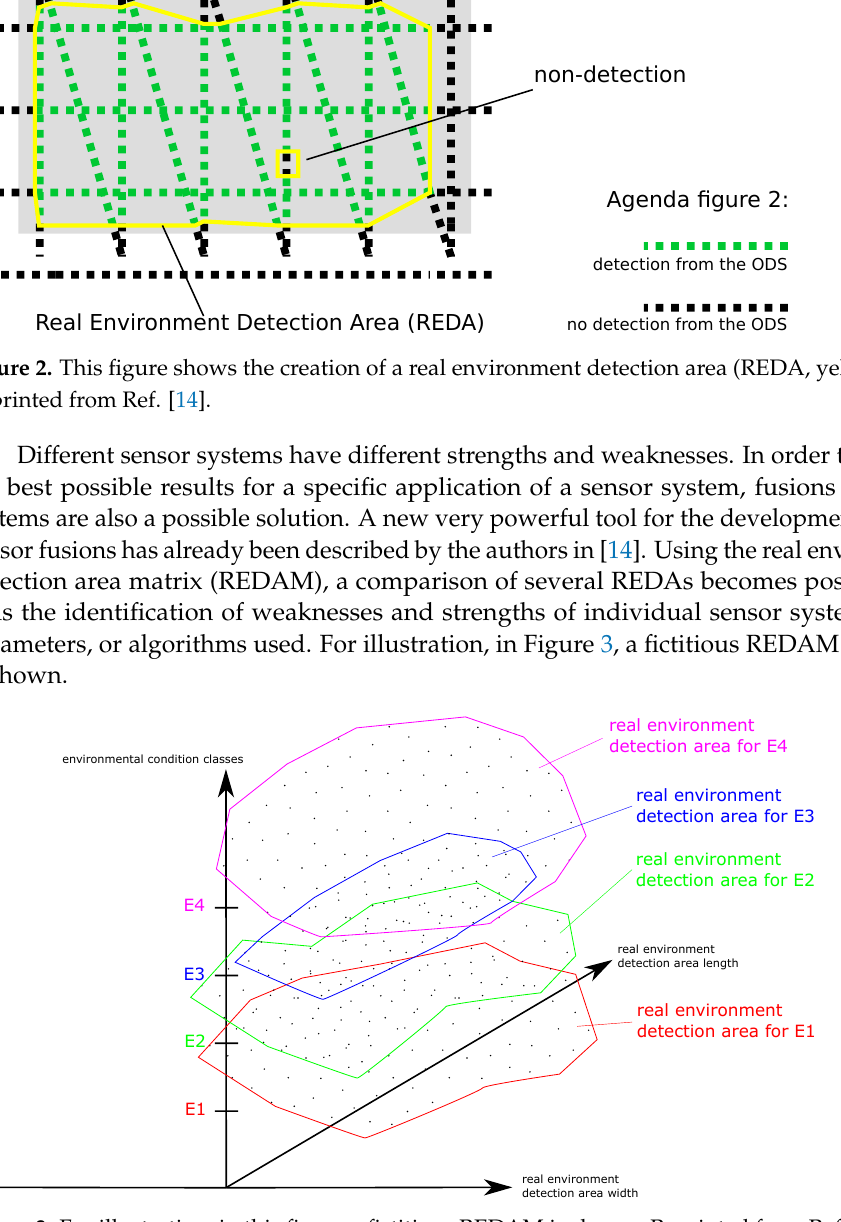
Figure 3. For illustration, in this figure a fictitious REDAM is shown. Reprinted from Ref. [14]. In the REDAM of Figure 3, a REDA is applied to the abscissa axis and the ordinate axis. On the application axis, different environmental condition classes are plotted. Thus, a three- dimensional overview of different REDAs for different environmental condition classes is created. In this context, an environmental condition class is a specific environmental condition or a real combination of different environmental conditions in one class. In this way, individual environmental condition classes are compared with each other in a simple way for a sensor system. Additionally, a REDAM can be used to compare different sensor systems for a special environmental condition. The comparison of different parameters or algorithms of a sensor system is also